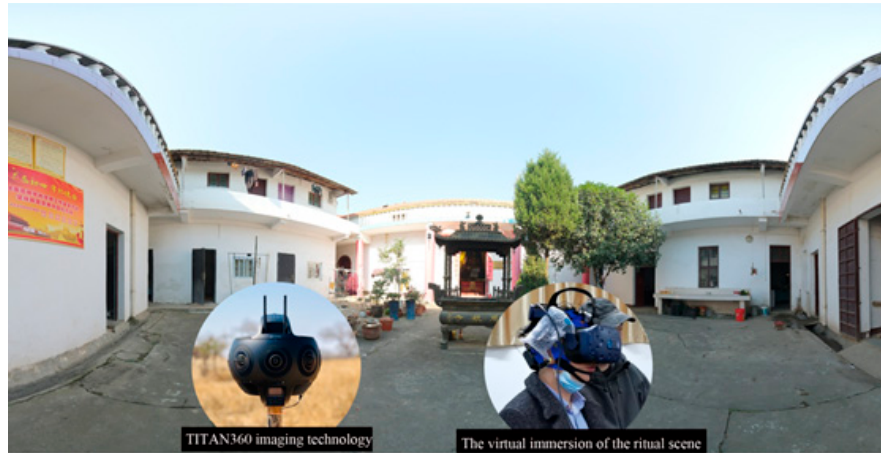
Figure 3. Scene simulation in the process of landscape reconstruction design.